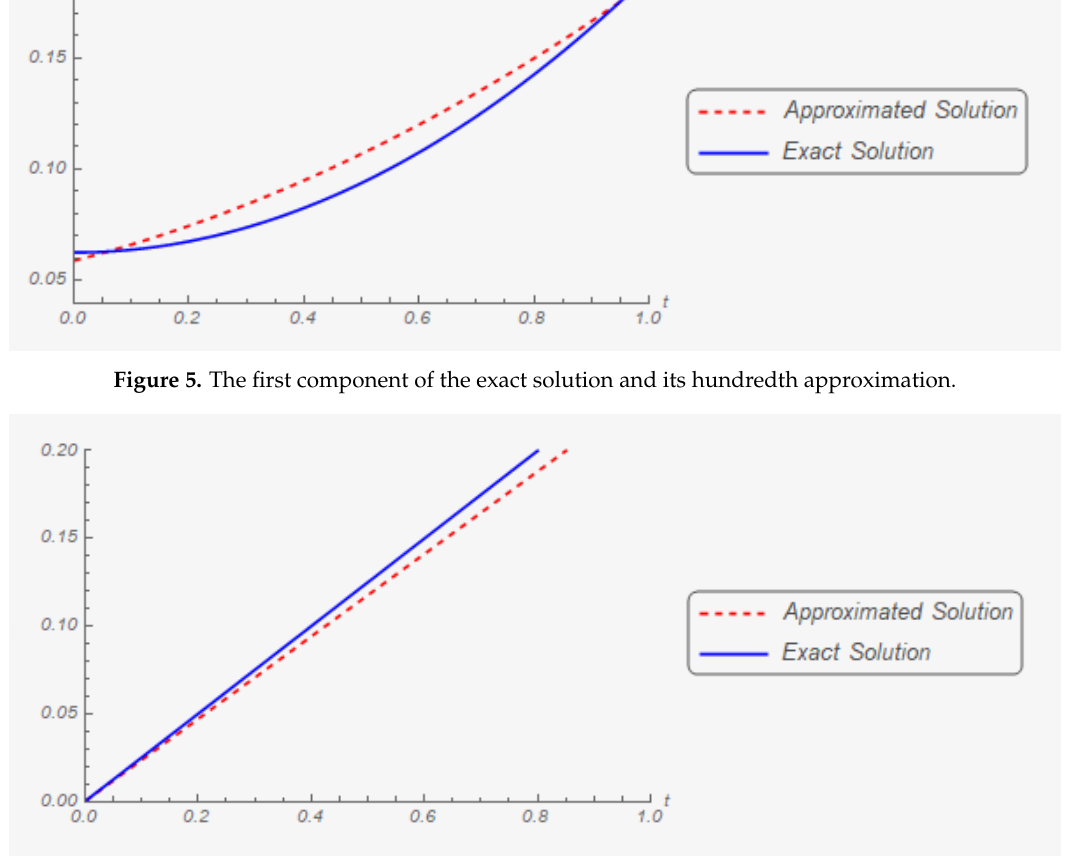
Figure 6. The second component of the exact solution and its hundredth